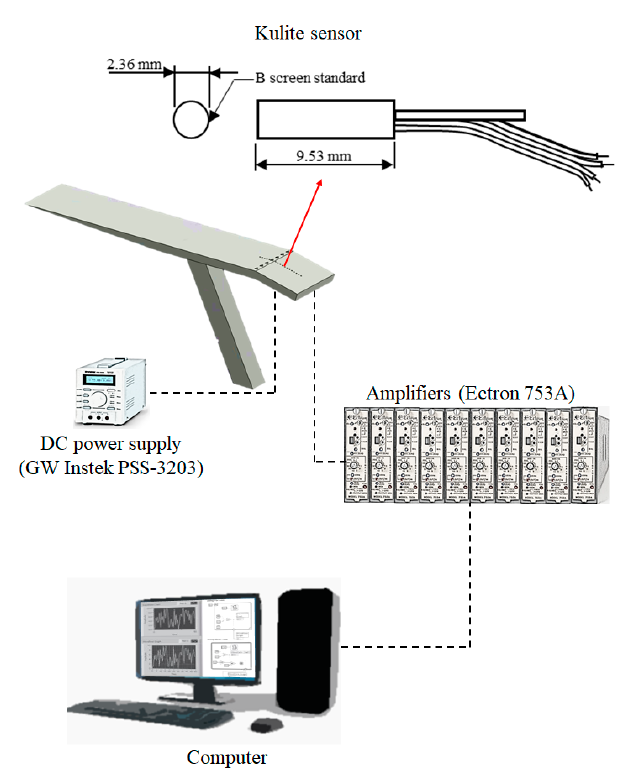
Figure 6. Experimental setup.